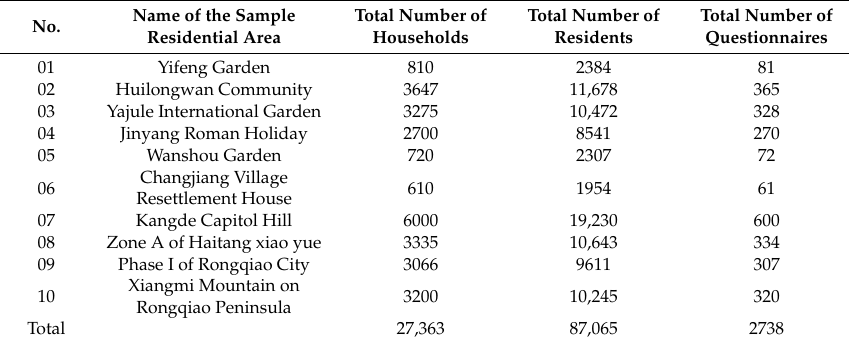
Table 1. Basic information of the sample residential areas 1 .